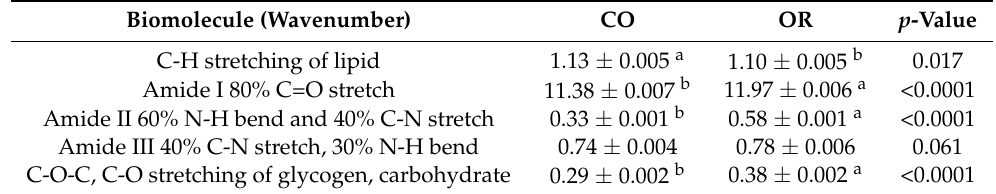
Table 8. TheintegralareaofaveragespectraofKRCbreastmeatfromdifferentraisingsystems(mean ± SD). Biomolecule (Wavenumber)